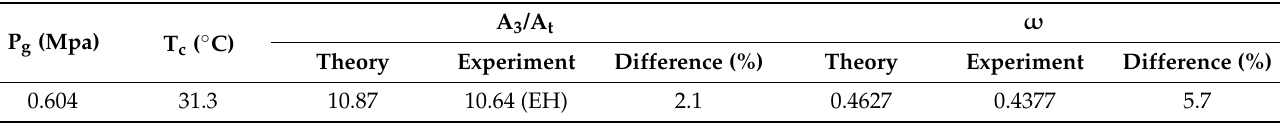
Table A2. Validation of the developed EES model based on the 1-D model of Huang et al. [34]. P g (Mpa)